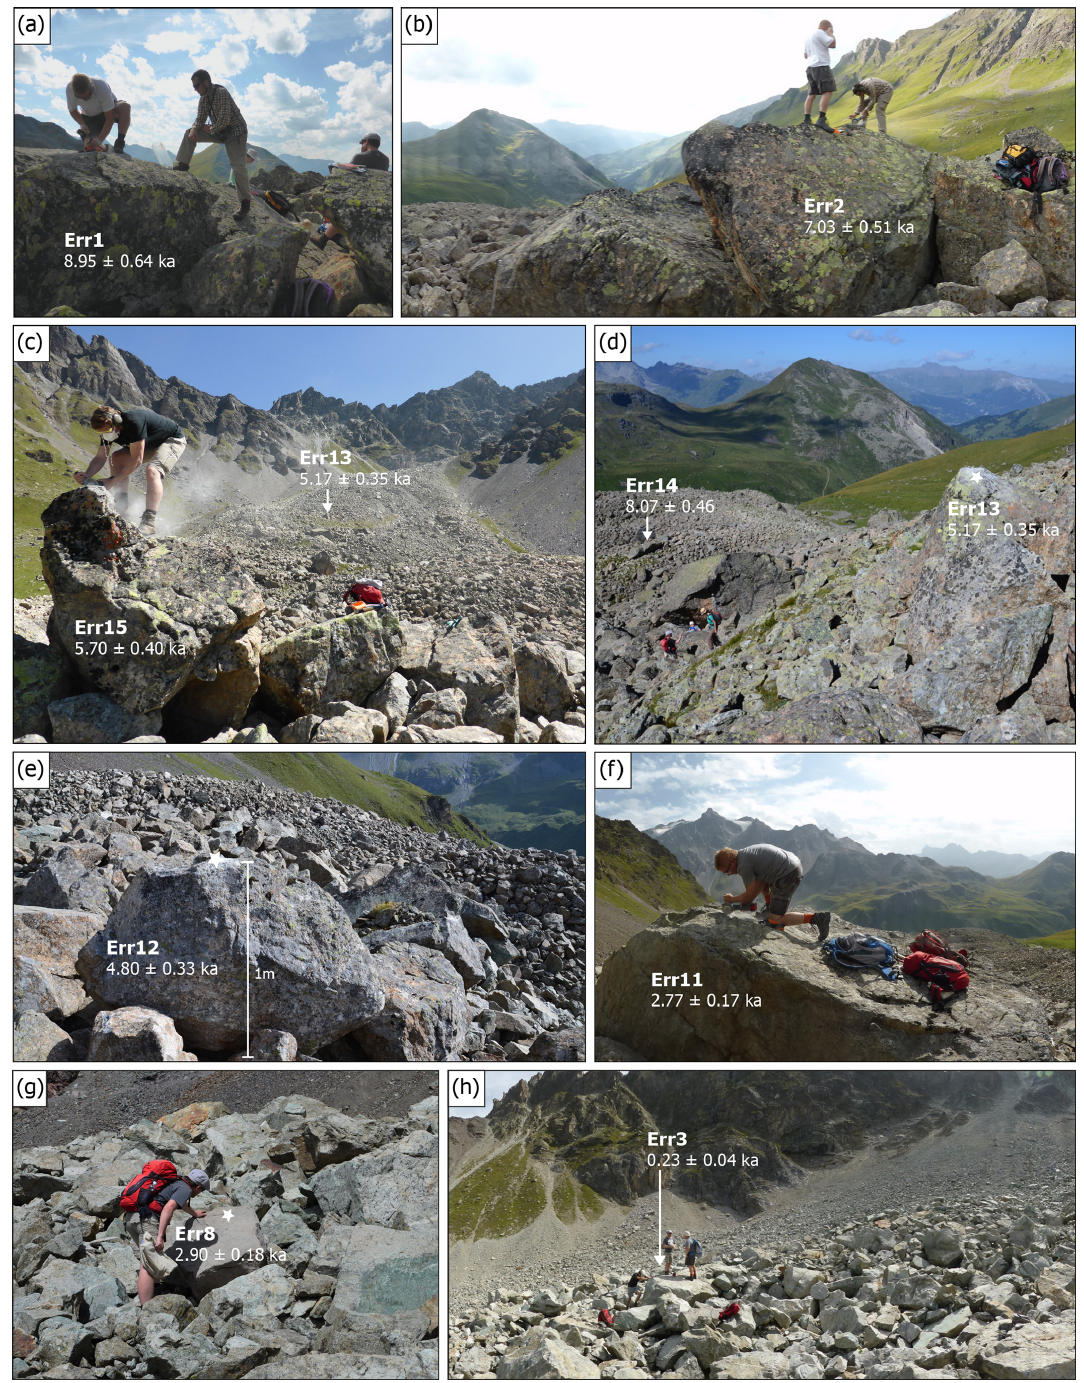
Figure 6. Field photographs of selected sampled boulders that are discussed in the text. In panels (d) , (e) , and (g) , the star marks the sampled surface. The numbers refer to the boulder exposure ages (in ka; uncertainties are 1 σ external